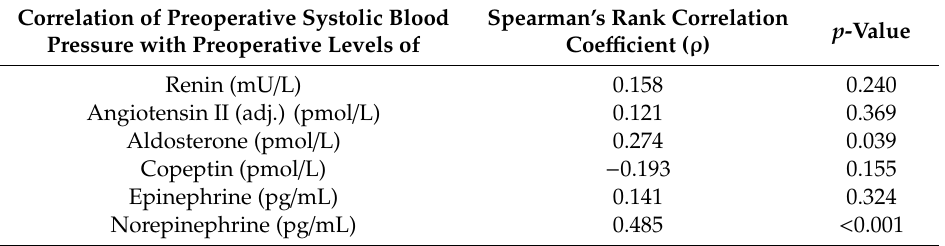
Table 3. Correlation of preoperative systolic blood pressure with different preoperative hormone levels. Table 4. Correlation of body mass index with di ff erent preoperative hormone